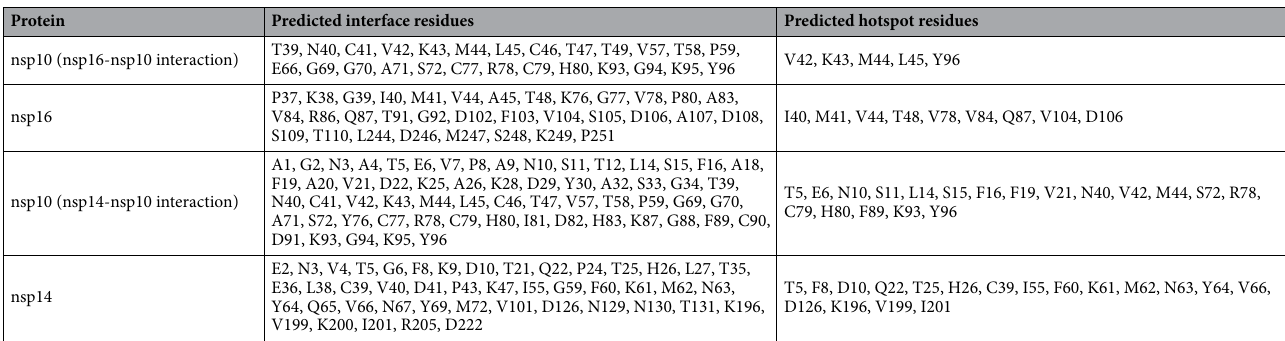
Table 1. The predicted protein–protein interface and hotspot residues of the SARS-CoV-2 nsp16-nsp10 and nsp14-nsp10